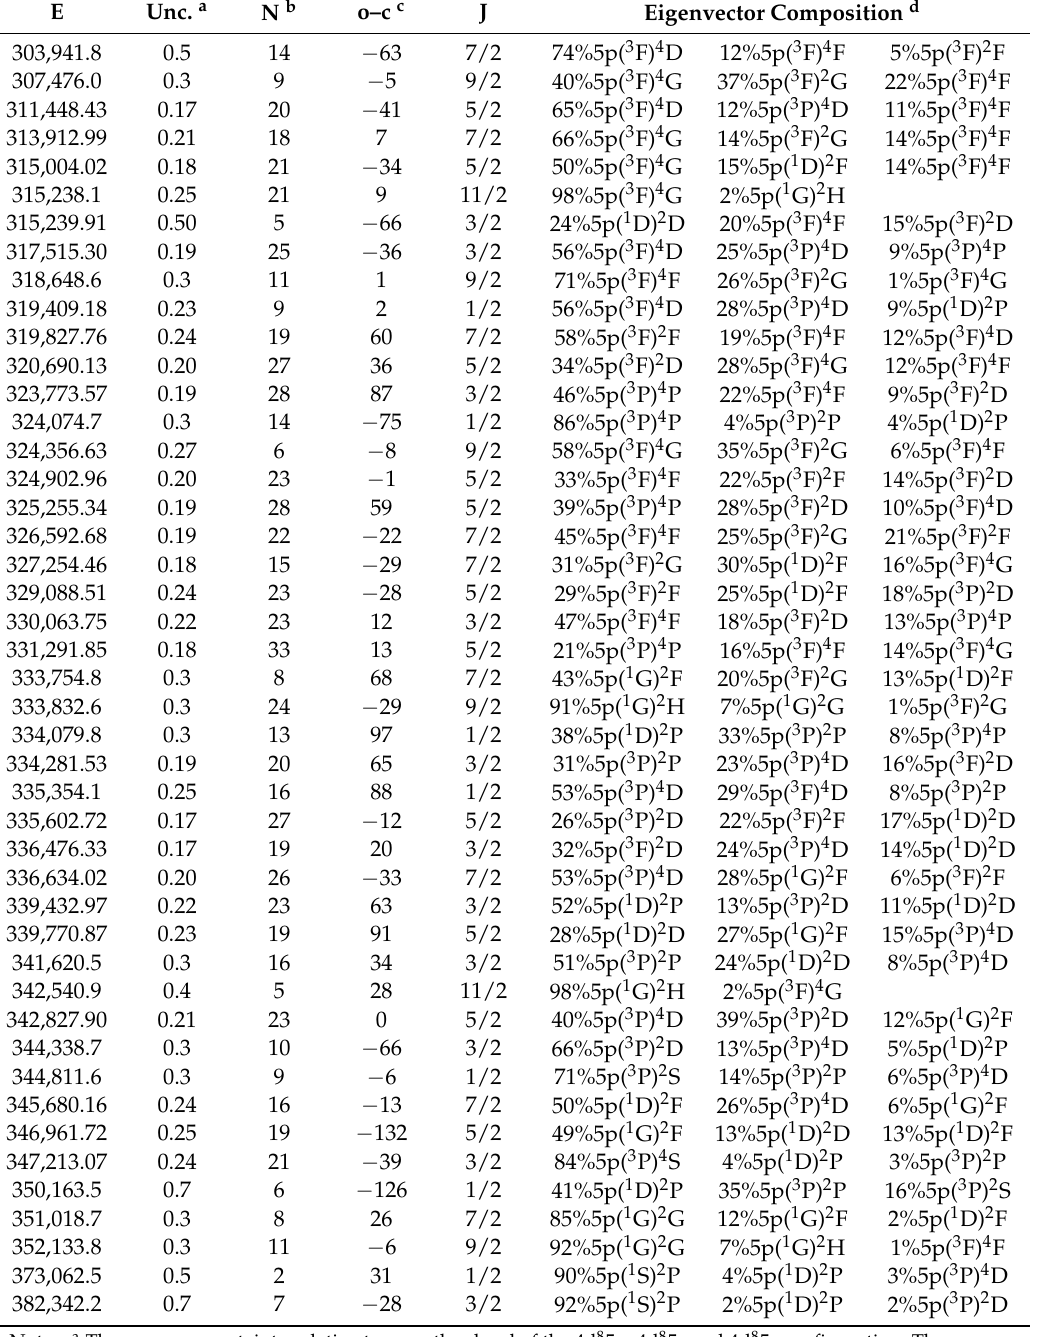
Table A3. Level energies (in cm − 1 ) of the 4d 8 5p configuration of Sn